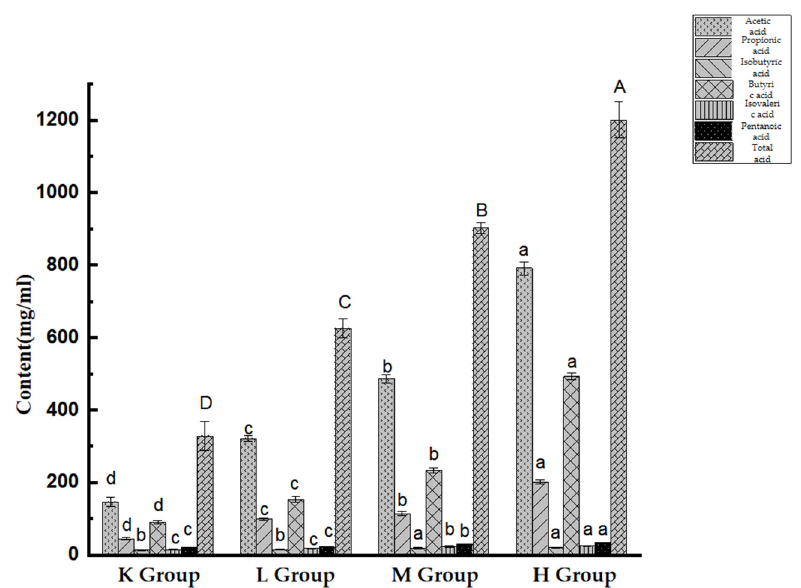
Figure 11. Content of short-chain fatty acids within mouse cecal contents. Different lowercase letters indicate significant differences between groups ( p < 0.05), and different capital letters indicate extremely significant differences between groups ( p < 0.01)